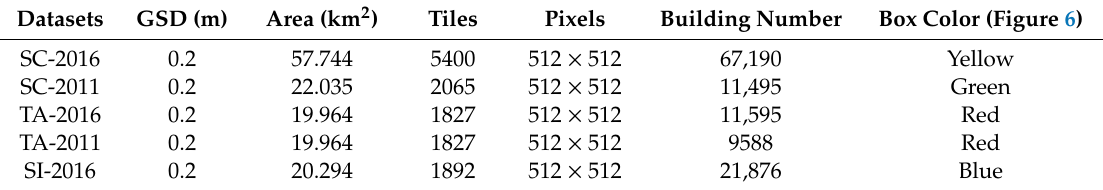
Table 1. Details of the sub-datasets in the WHU building change detection